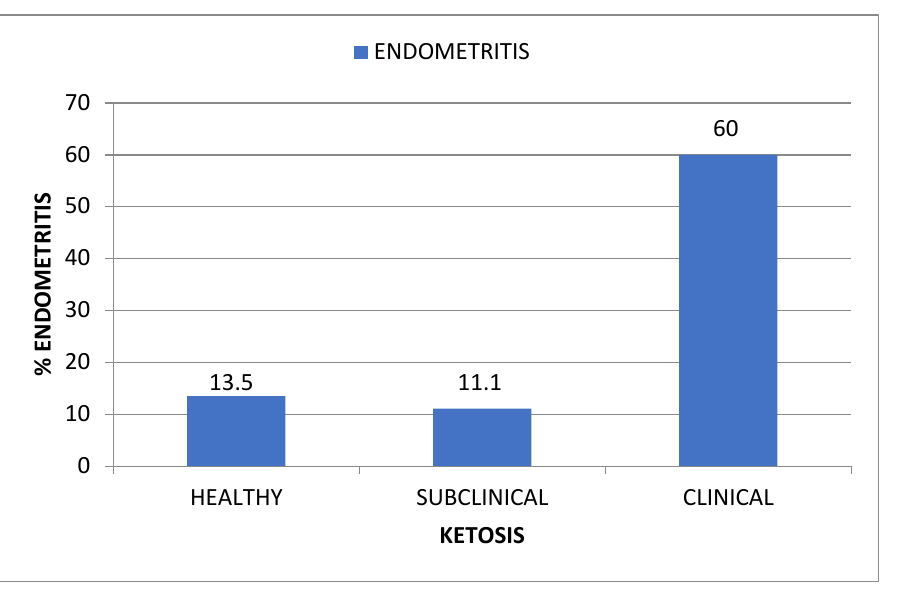
Figure 4. Incidence of endometritis (% endometritis) regarding the occurrence and the type of keto- sis.